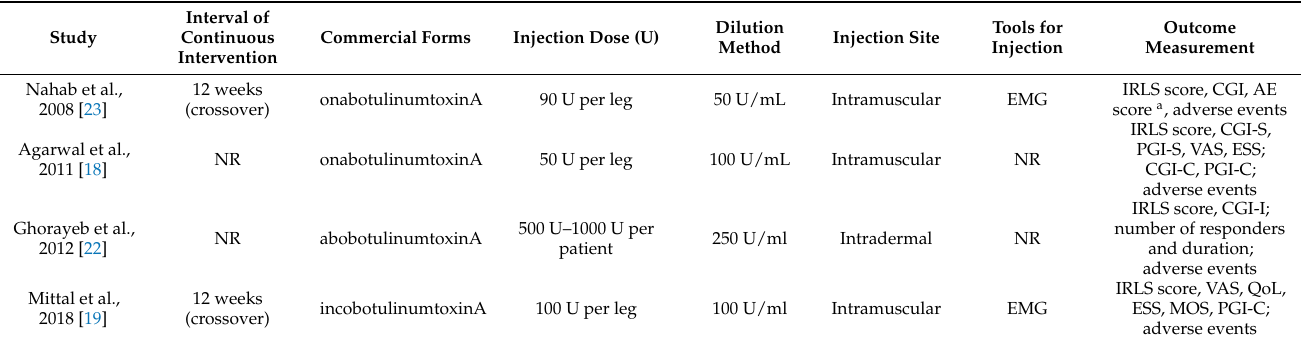
Table 2. The summarized extracted data from the included